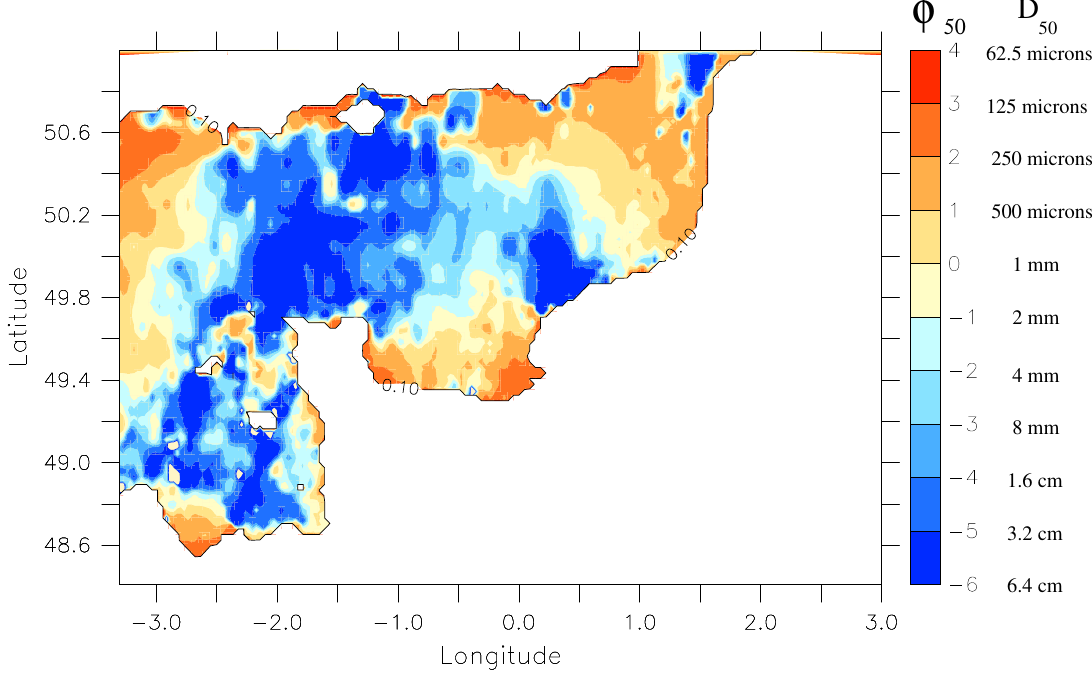
Figure 3. Interpolated median sieve diameter expressed in Wentworth’s grain-size scale φ = − log ( D ) (with D in 50 50 50 2